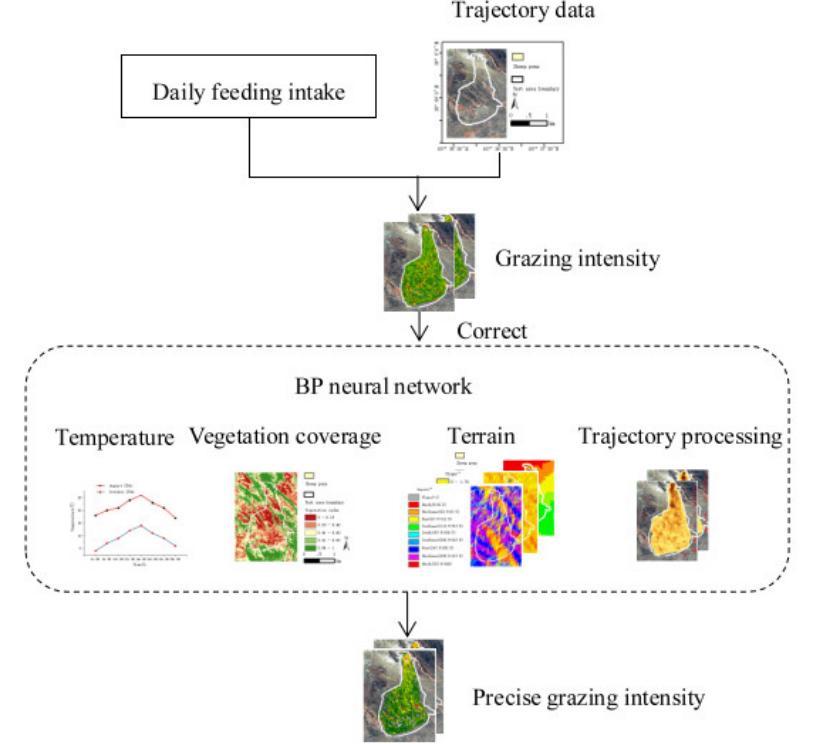
Figure 1. Overall flow chart of research scheme.